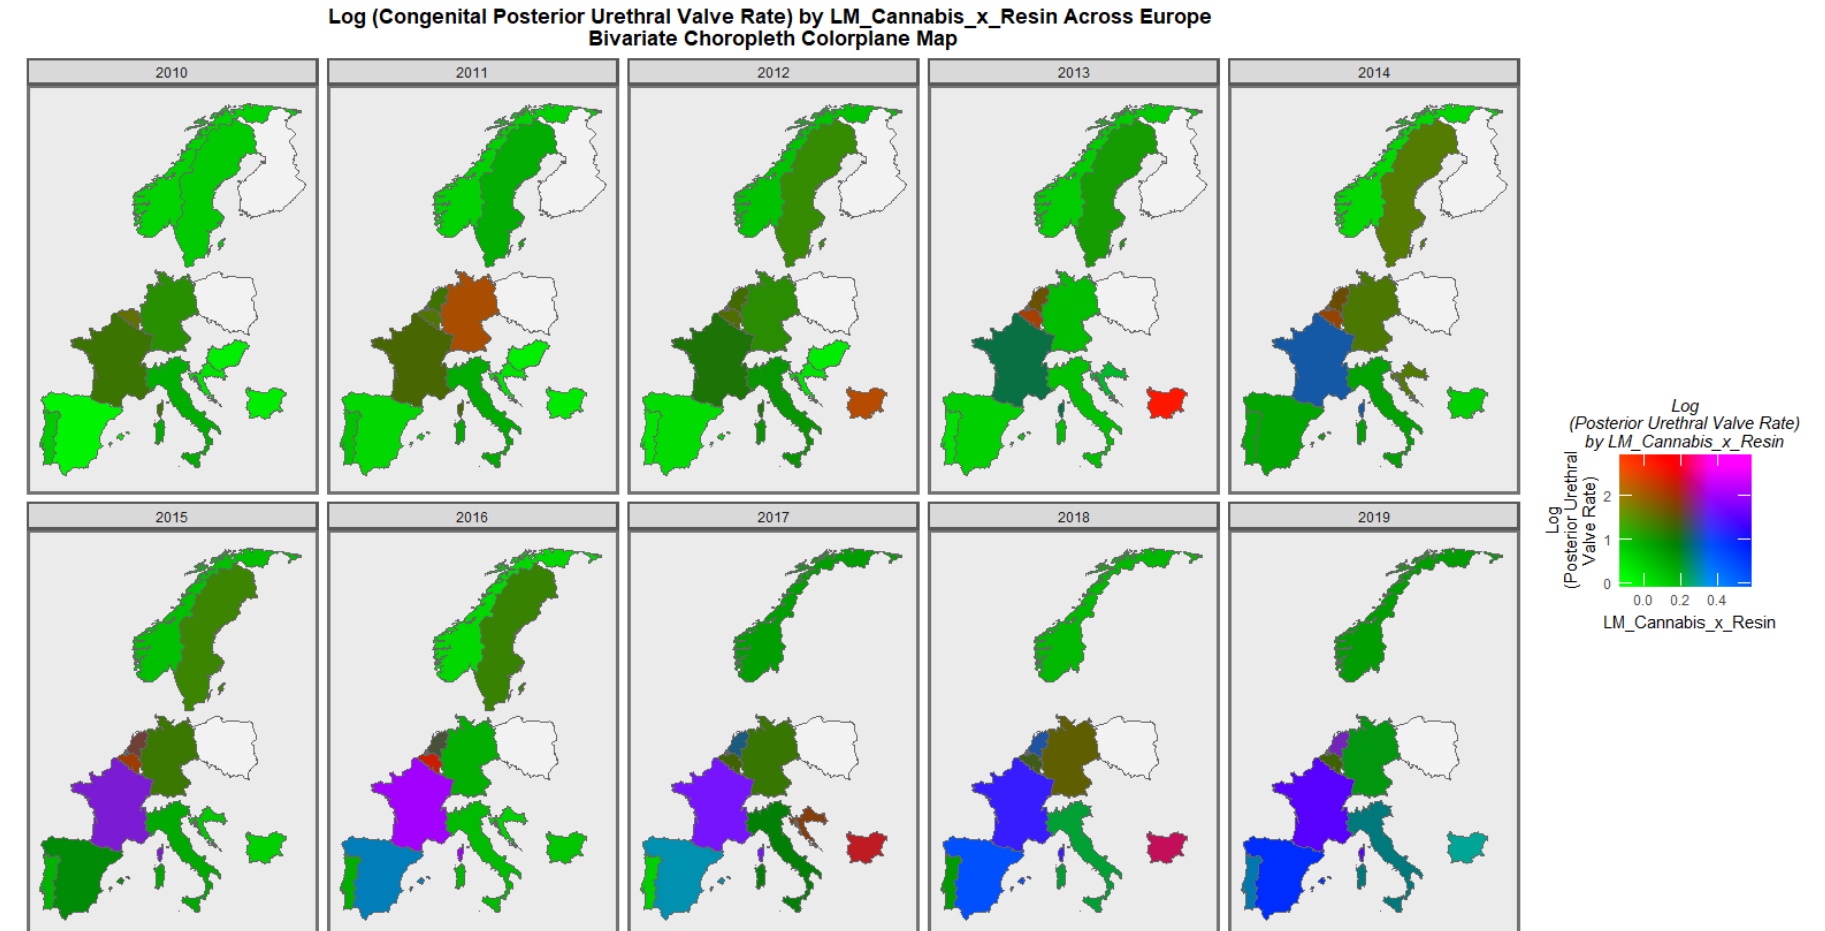
Figure 10. Colorplane bivariate time sequential map-graph of log (posterior urethral valve congenital anomaly rate) by last month cannabis use: cannabis resin THC concentration across surveyed European nations over time.